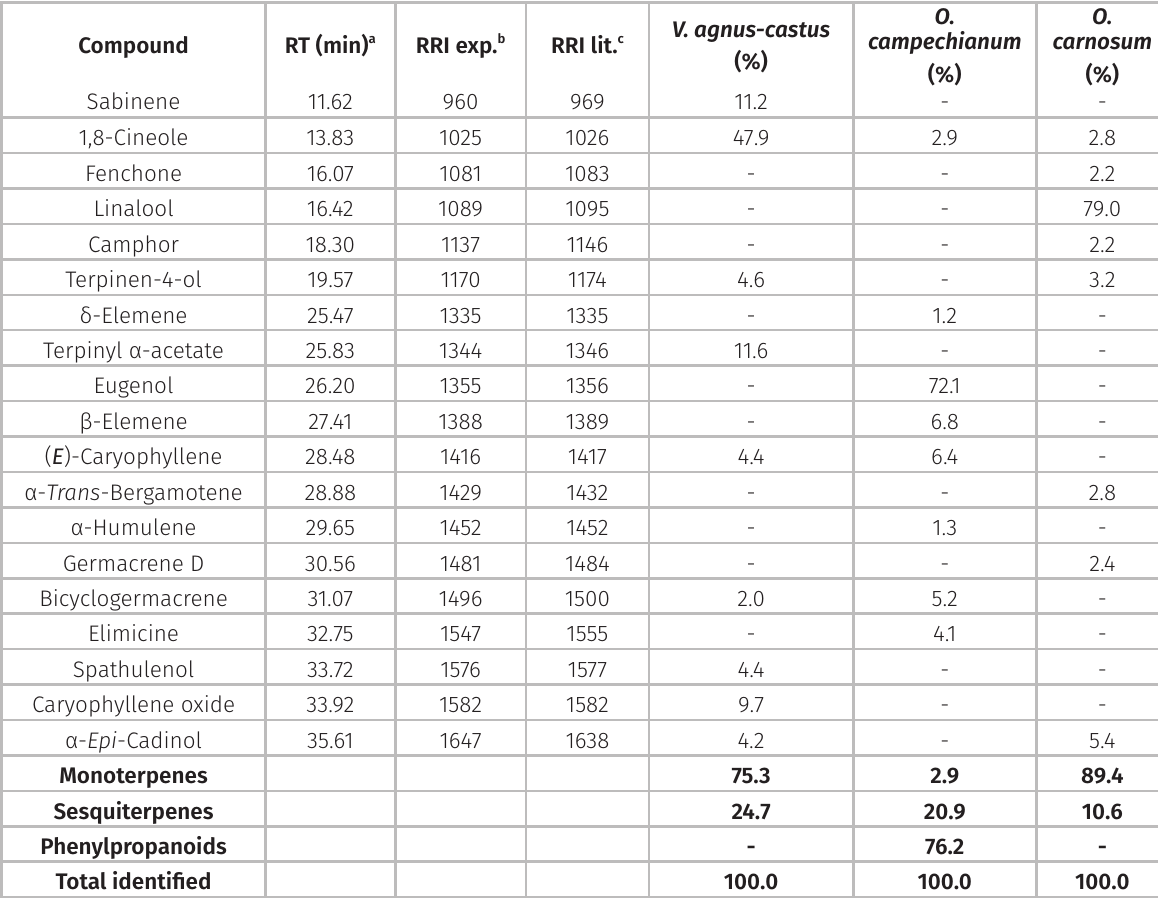
Table I. Chemical composition of essential oils of V. agnus-castus , O. campechianum and O. carnosum .